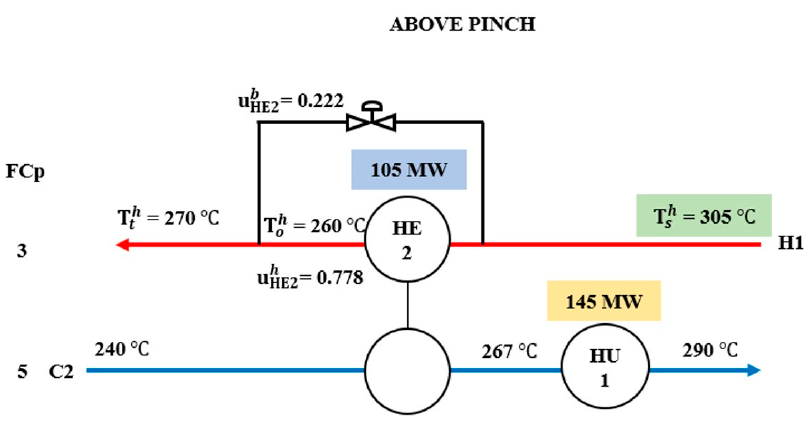
Figure 14. HEN design with T S decreased for hot stream H1 above the pinch.